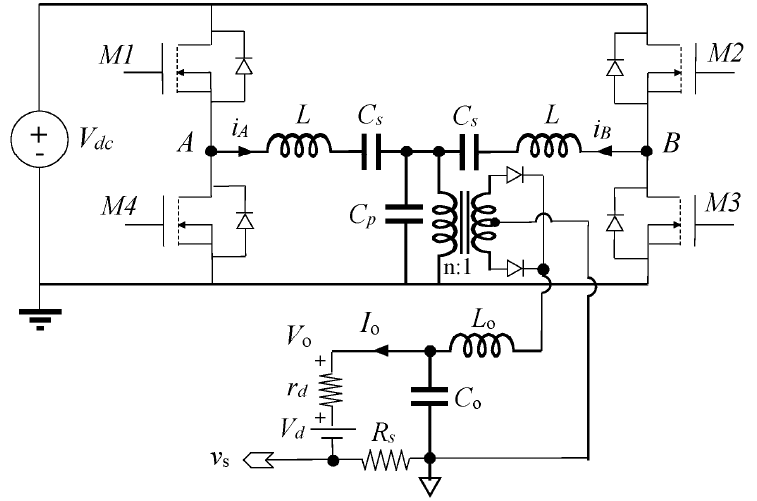
Figure 1. Two-phase LC s C p resonant converter.